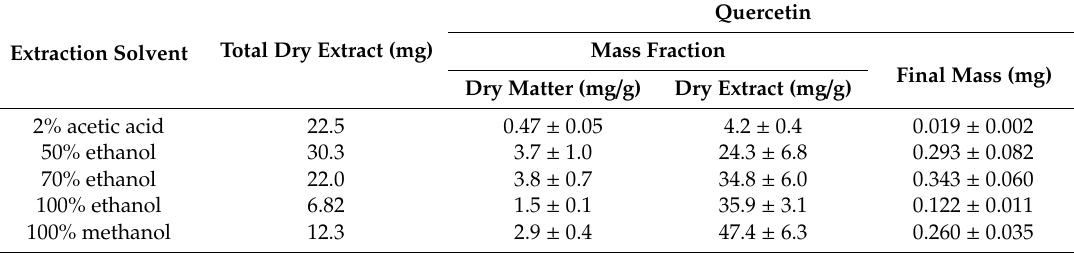
Table 2. Quercetin recoveries obtained from 200 mg of lyophilized onion skin (original dry matter) according to the solvent optimization conditions (1:10 mass-to-liquid ratio; 25 ◦ C; 15 min).